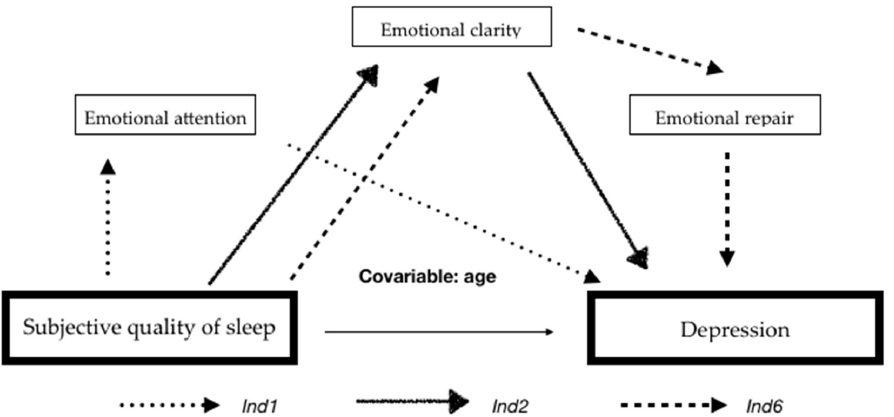
Figure 2. Mediation model in the relationship between subjective sleep quality and depression.